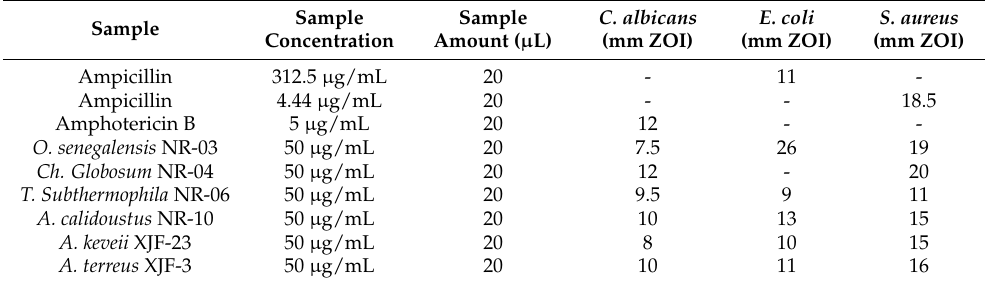
Table 2. Antimicrobial activity (ZOI) of endophytic fungi associated with medicinal plant V. an- thelmintica